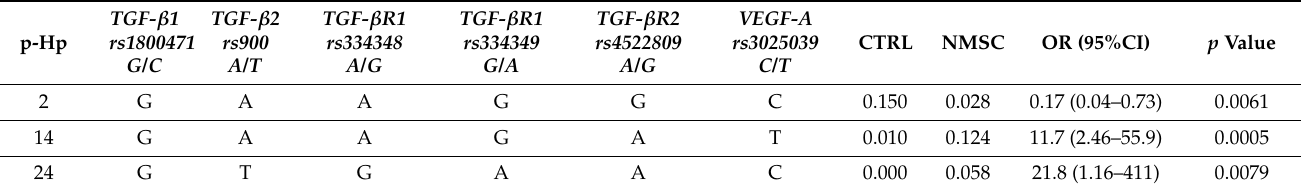
Table 7. Significantly different results obtained analyzing frequencies of 31 pseudo-haplotype (p-Hp) containing major or minor alleles of TGF- β and VEGF-A SNPs, in non-melanocytic skin cancer (NMSC) patients and control (CTRL)